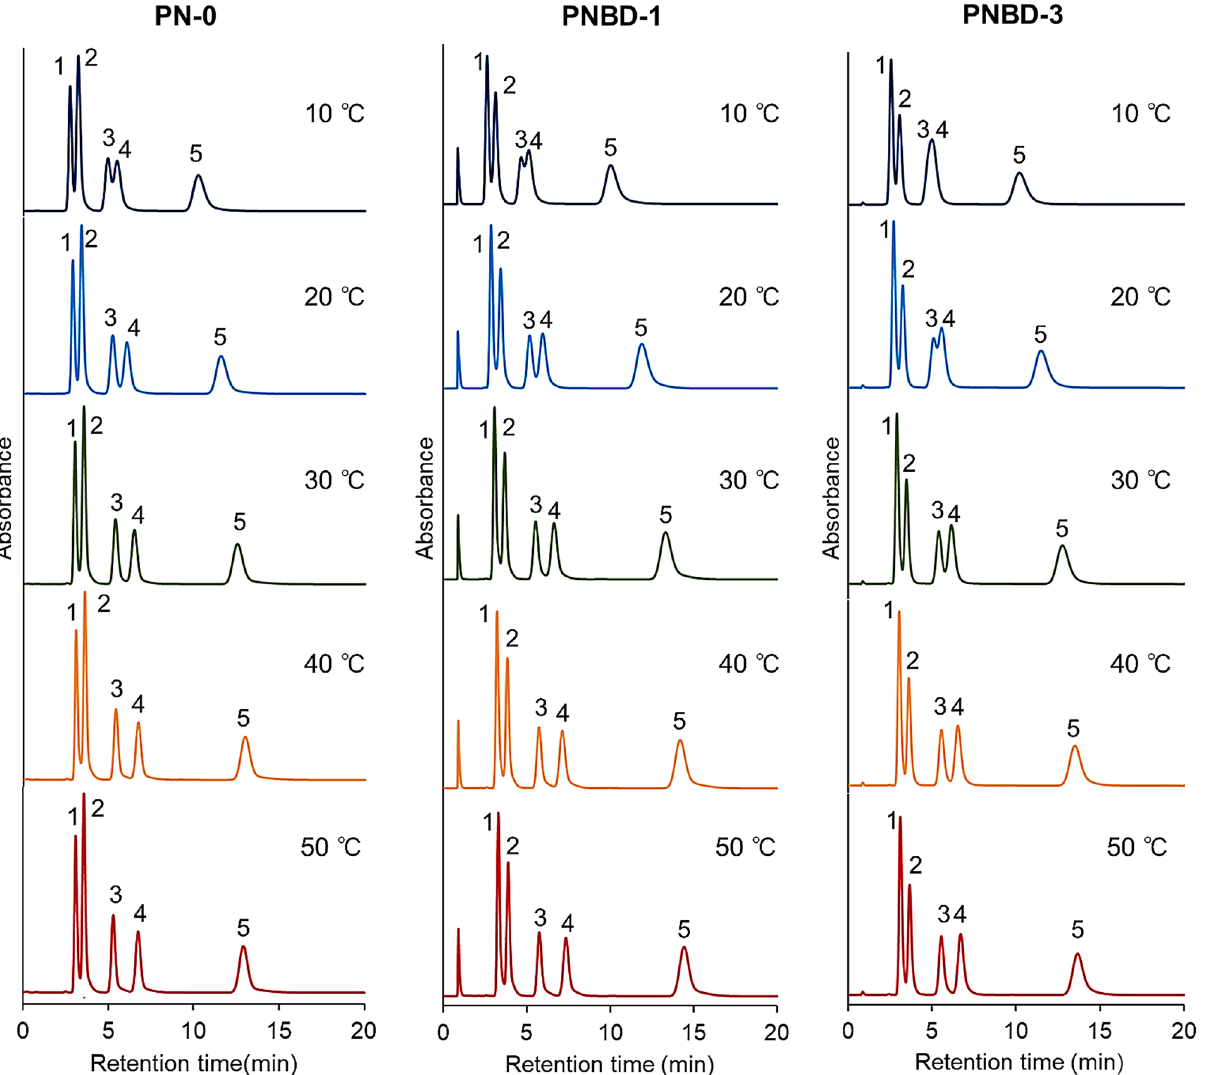
Figure 3. Chromatograms of steroids obtained using the prepared thermoresponsive-cationic-polymer- hydrogel-modified silica beads. Mobile phase: pure water; mobile phase flow rate: 1.0 mL/min; detection wavelength: 254 nm. Peaks 1: hydrocortisone, 2: prednisolone, 3: dexamethasone, 4: hydrocortisone acetate, and 5: